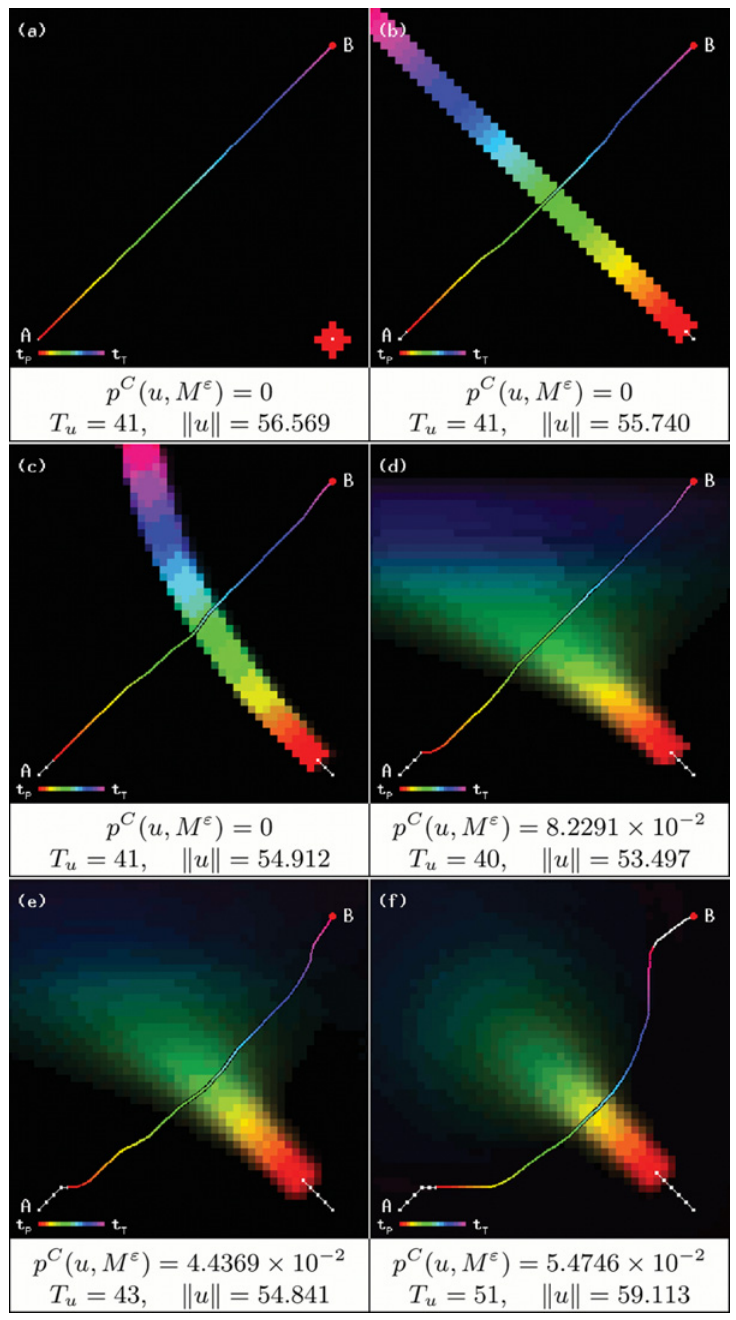
Fig 6. Example of sequential calculation of a trajectory from point A to point B with one obstacle. We use T = 45, (cid:2) = 10 − 3 and r R + r 1 = 2.